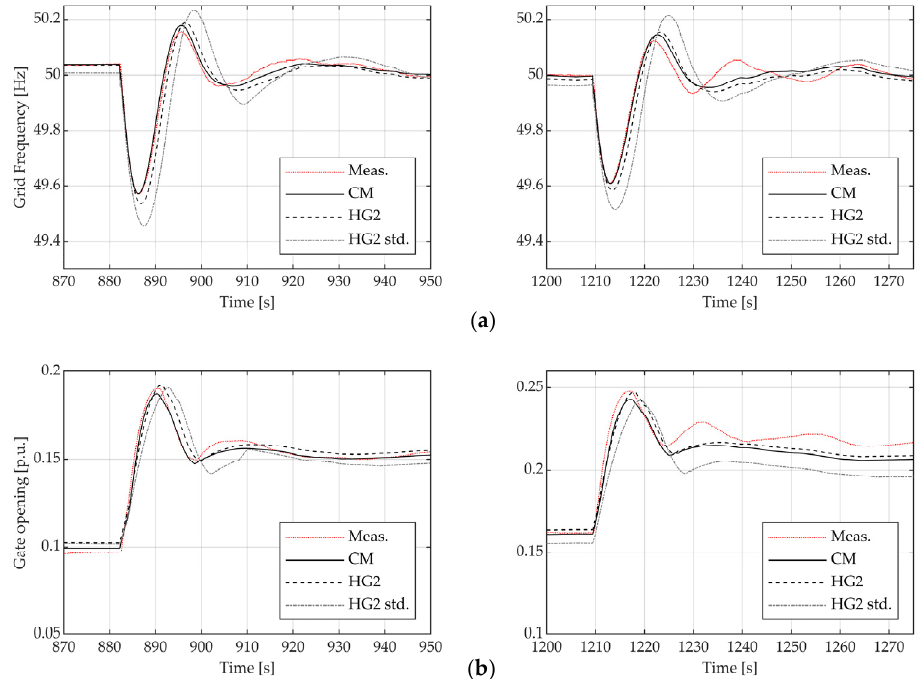
Figure 10. Comparison between simulation results and measurement recordings of the S L1 and S L2 events for ( a ) the grid frequency and ( b ) the gate opening of G1 for different model of the PFC.